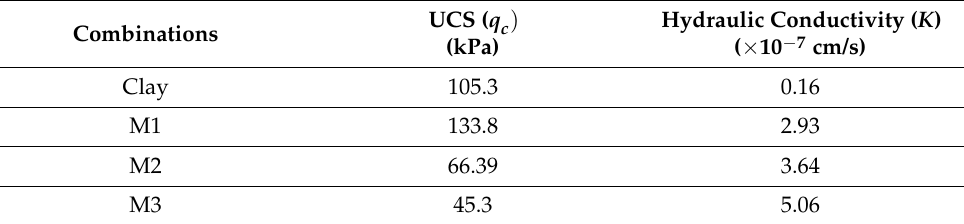
Table 5. Variation of UCS and Hydraulic Conductivity of clay–GS